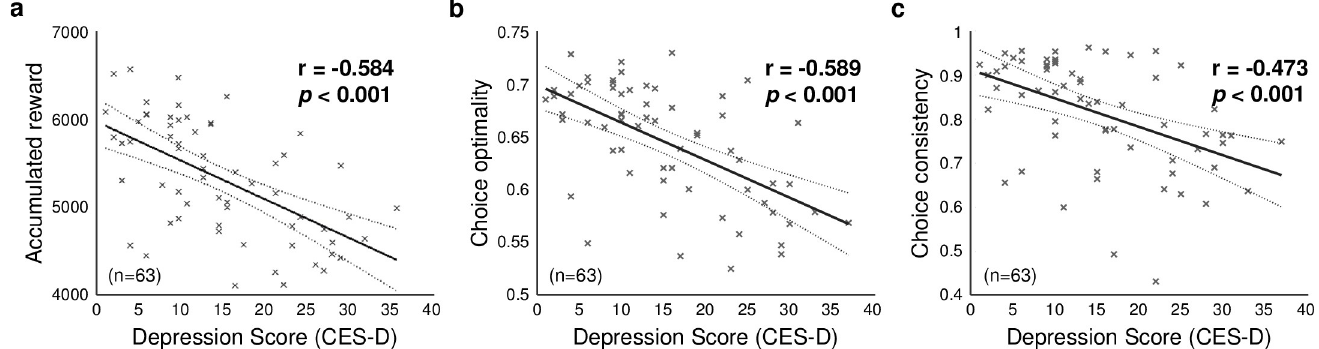
Fig 2. Behavioral results. (a) Relationship between the individual depression score (CES-D) and accumulated reward (n = 63). The task performance decreases as the depression score increases. (b) Relationship between depression score and the choice optimality (n = 63). The choice optimality is inversely proportional to the depression score. (c) Relationship between the depression score and choice consistency in the first state (S 1 ) (n = 63). The choice consistency index is negatively correlated with the depression score.